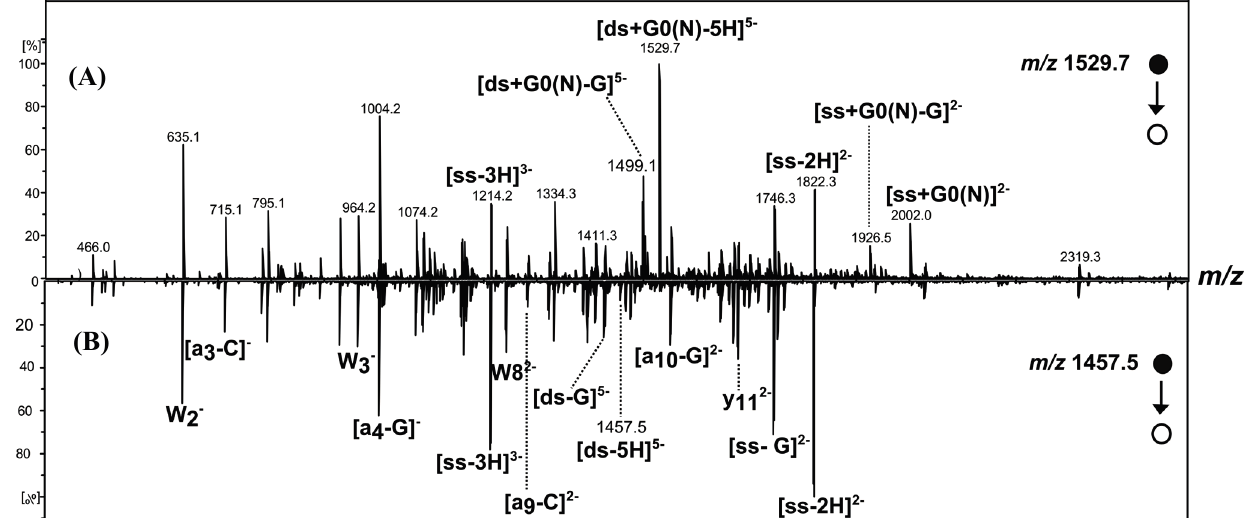
Figure 6. Negative-ion ESI MS/MS spectra of [ ds /G0(N)-5H] 5 − ( m/z 1529.7) ( A ) and [ ds -5H] 5 − ( m/z 1457.5) ( B